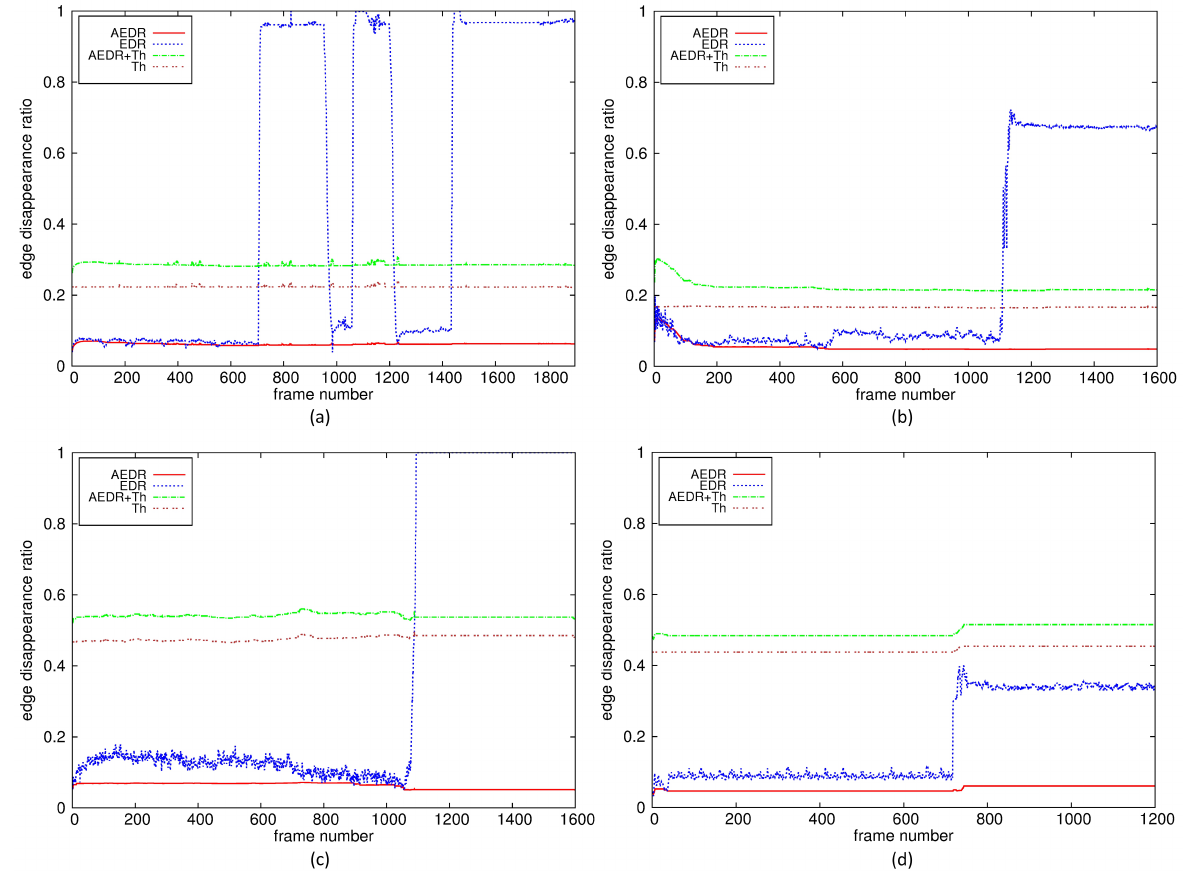
Figure 8. Tamper detection with the adaptive threshold for different scene contents: ( a ) daytime sequence, successive covered events; ( b ) daytime sequence, plain background; ( c ) nighttime sequence, defocused; ( d ) nighttime sequence,